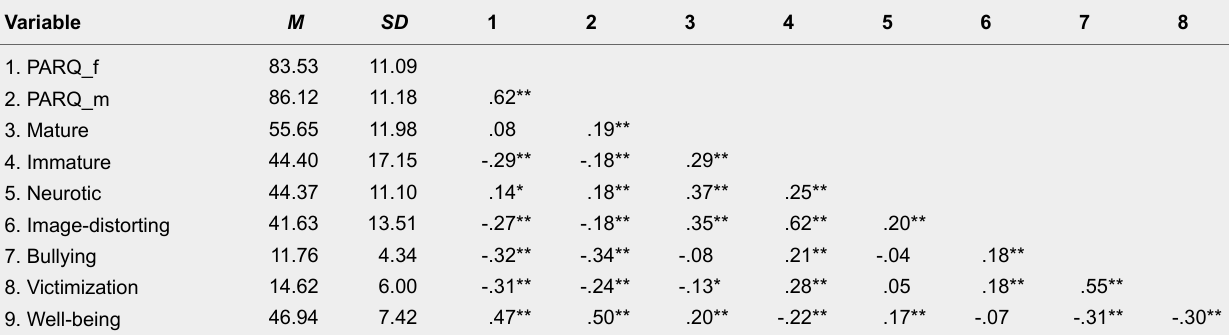
Means, Standard Deviations and Inter-Correlations Among Study Variables Variable